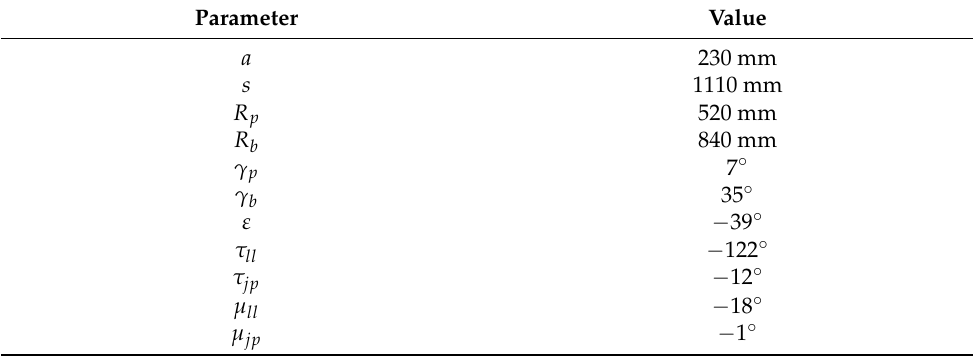
Table 1. Example of geometric parameter values for some